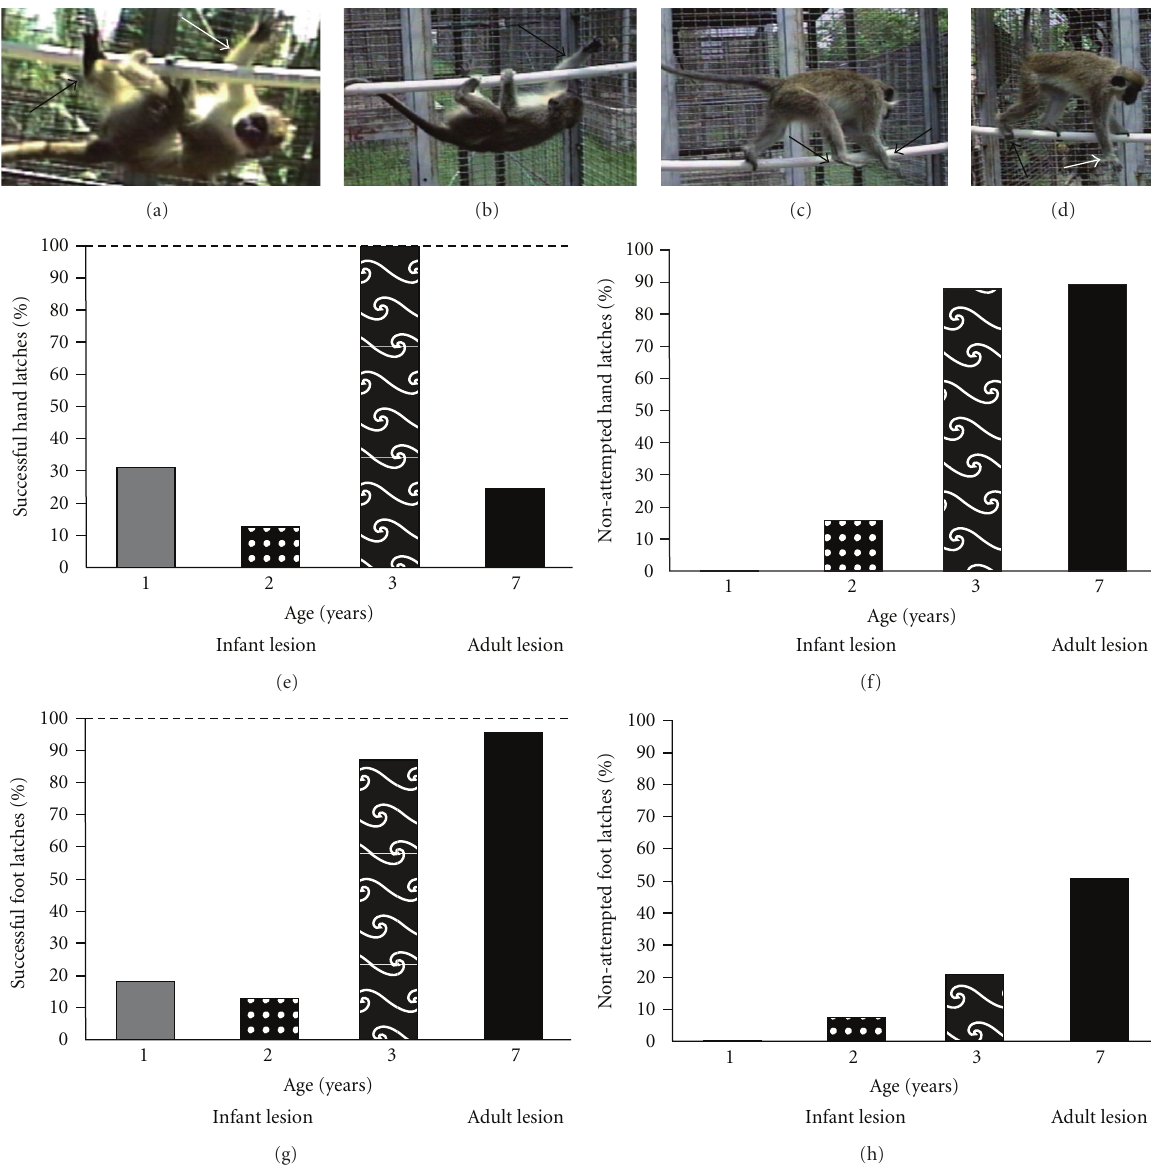
Figure 4: At a young age, the subjects made a significant number of unsuccessful attempts to grab the horizontal bar with their hands and would transverse the bar upside down (a and e). The subjects would typically overreach the bar with their arms and glide their arms across the bar until their hands were able to latch on (white arrows in a and b). The lower limb also had di ffi culty latching onto the bar during the first two postoperative years after the surgery (black arrow in panels a and g). At two years of age, the monkeys began not to attempt to use the contralateral upper limb to transverse the bar (black arrows in panel c). Typically the subject would successfully use the a ff ected hind limb (black arrow in panels d and h) and would not attempt to use the front limb (white arrow in panels d and f) to transverse the horizontal bar. By 2 years after surgery the subjects were able to walk upright across the bar. Dashed line (e and g) represents the expected value for a normal monkey. % successful was determined as successful latches (hand or foot)/total attempts to latch onto the horizontal bar. The ipsilateral side of the body acts as an internal control for normal motor movements and did not show any paretic movements. Years 1, 2, and 3 refer to the age of the infant-lesioned subjects at testing which also corresponds to the years after lesion. For the adult-lesioned subjects, year 4 refers to the number of years after initial surgery. Adapted from